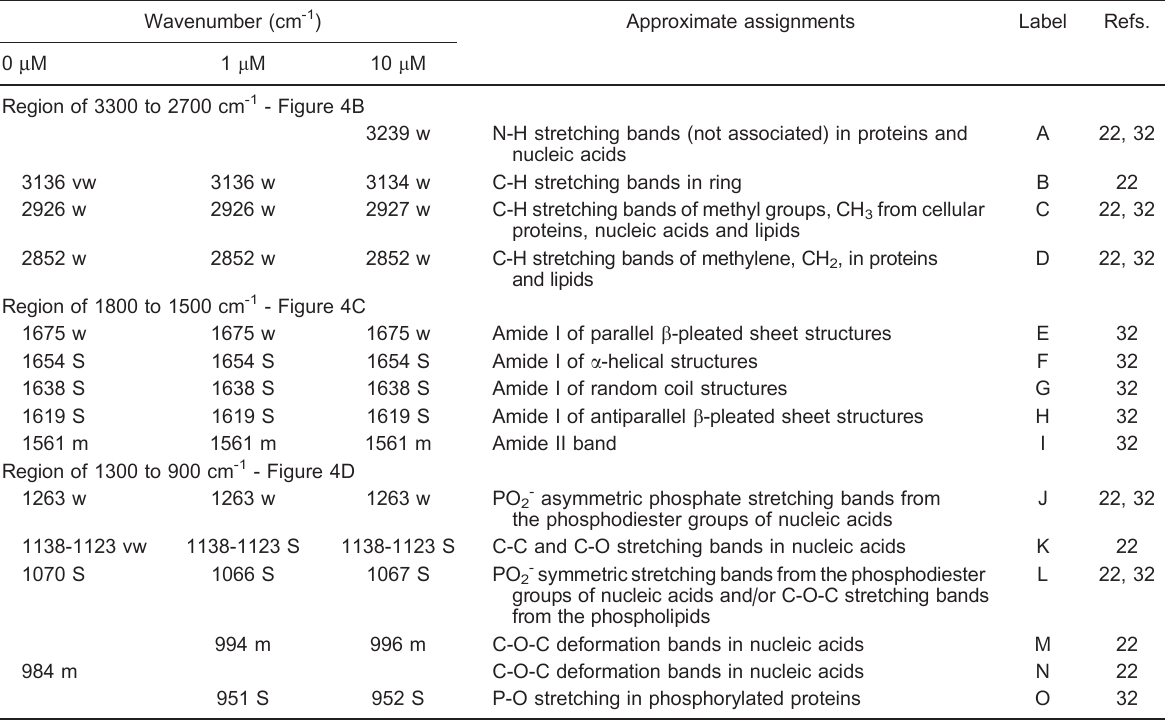
Table 1. Band assignment of FTIR in the regions of 3300-2700, 1800-1500, and 1300-800 cm -1 . Wavenumber (cm -1 ) Approximate assignments Label Refs.